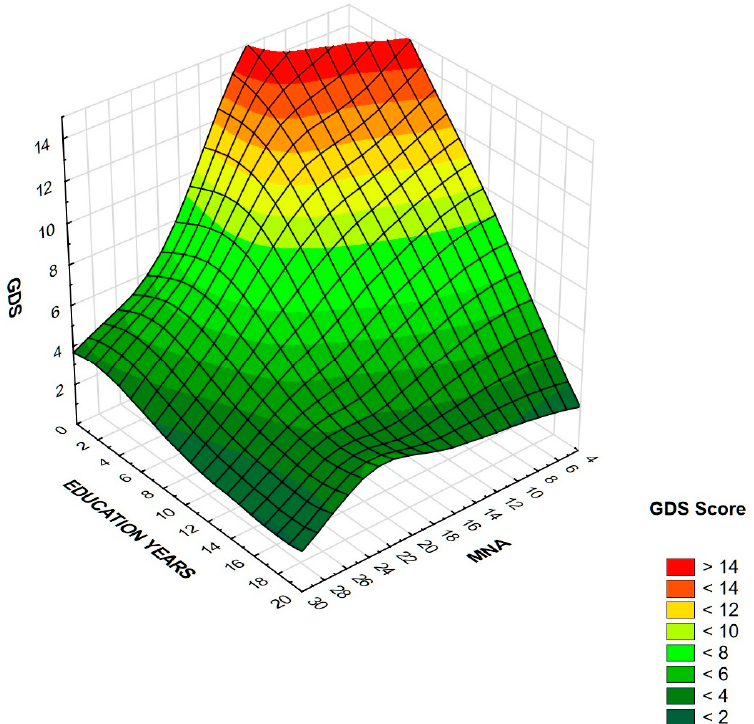
Figure 3. Association between GDS score, education years, and MNA in men. Higher GDS is asso- ciated with lower education level and lower MNA score in this group.